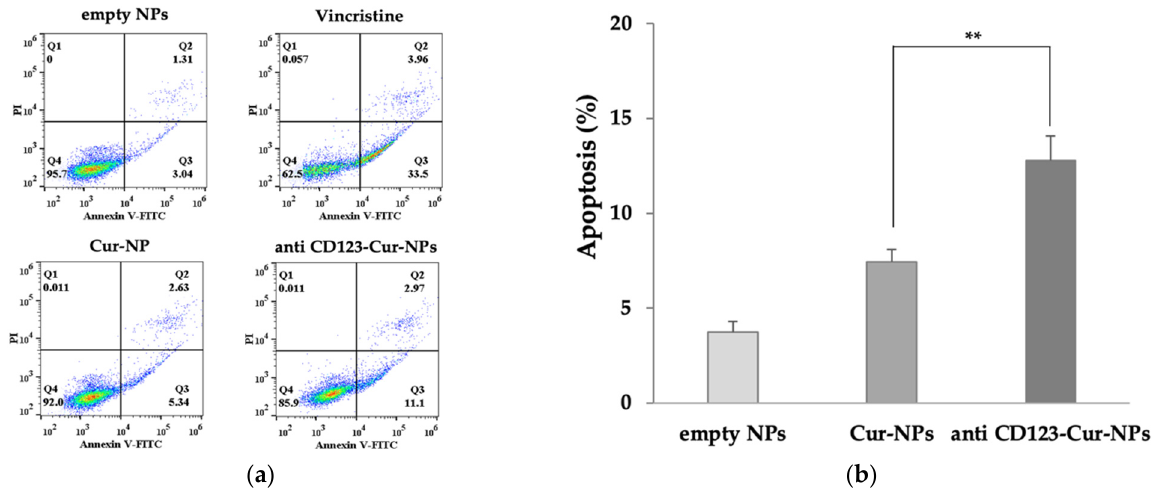
Figure 7. Apoptosis assay using flow cytometry after staining with double annexin V-FITC/propidium iodide (PI). KG-1a cells were treated with empty NPs, Cur-NPs, and anti-CD123-Cur-NPs. ( a ) Representative flow cytometry dot plot indicating the cell population in apoptotic and necrotic quadrants after treatment with different NPs. ( b ) The percentage of apoptotic cells was statistically compared. The data are shown as mean ± SD from three independent experiments. ** p < 0.05 between groups.